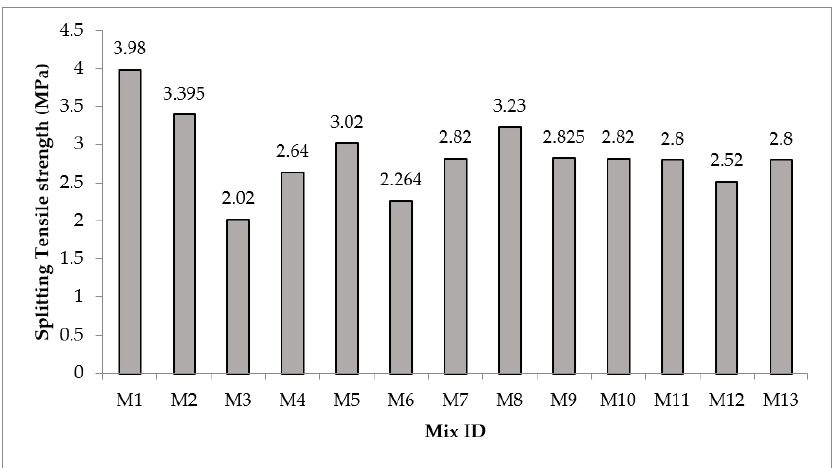
Figure 4. Splitting tensile strength at 28 days. By RSM ANOVA, the actual equation for estimating the 28-day STS of the concrete with the interaction of two variables, i.e., fly ash and GO, are presented as Equation (2). The effect of fly ash and GO on the STS of the SCC is plotted in the form of 3-dimensional response surface plot as presented in Figure 5.